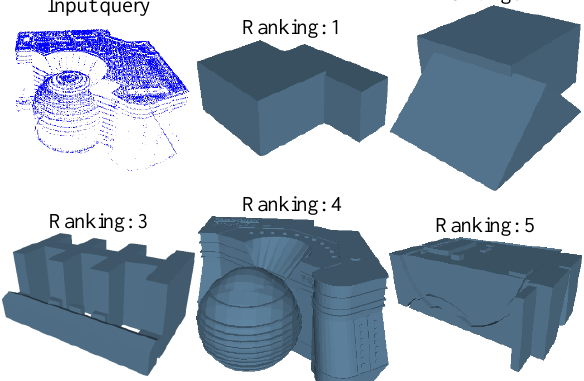
Figure 11. Retrieval results of the compared